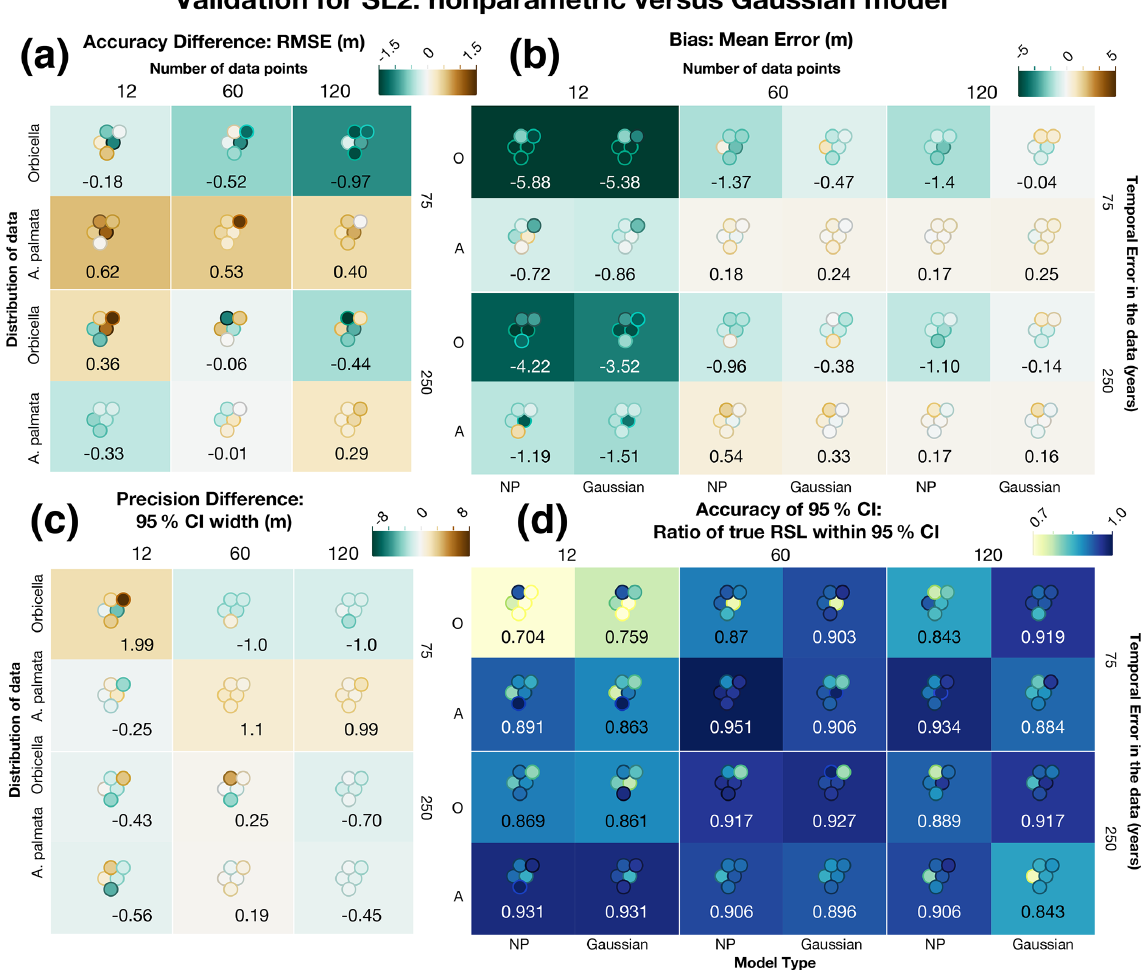
Figure 8. Comparison of several metrics to validate the new nonparametric (NP) model against the Gaussian model with the same exact data using sea-level curve SL2. The Gaussian model includes the same quantity of data as the nonparametric model but approximated with normal distributions instead of with kernel densities for both Orbicella spp. (O) and Acropora palmata (A). The differences (a, c) represent the Gaussian metric minus the nonparametric metric. The box colors represent the average metric value (also shown numerically), and each dot represents the individual test, positioned to match the corresponding test run. (a) The difference in the average accuracy of the models, measured by the root-mean-square error (RMSE). (b) Average bias for each model, measured by the mean error, where brown (green) represents positive (negative) bias. (c) The difference in the precision of the model predictions, measured by the width of the 95% credible interval (CI). (a, c) Brown (green) values are positive (negative), signifying that the nonparametric model had less (more) error or more (less) precision. (d) Average accuracy of the uncertainty intervals, measured by the ratio of true values within the 95%CI. Darker blues represent more coverage (better performance). (b, d) The model type is shown at the bottom of each column. Individual test results for all metrics are shown in Table